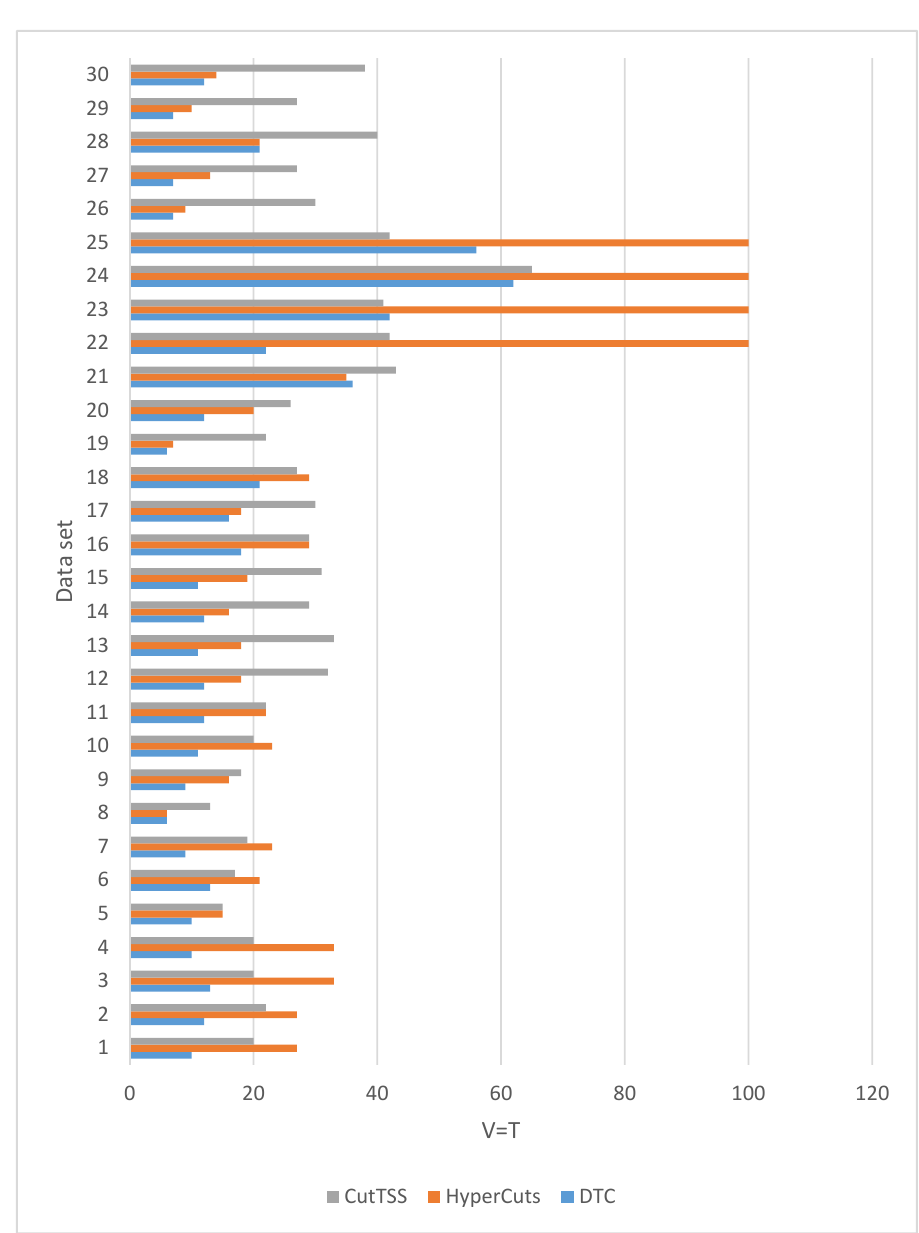
Figure 4. The experimental result when V = T (matching time).